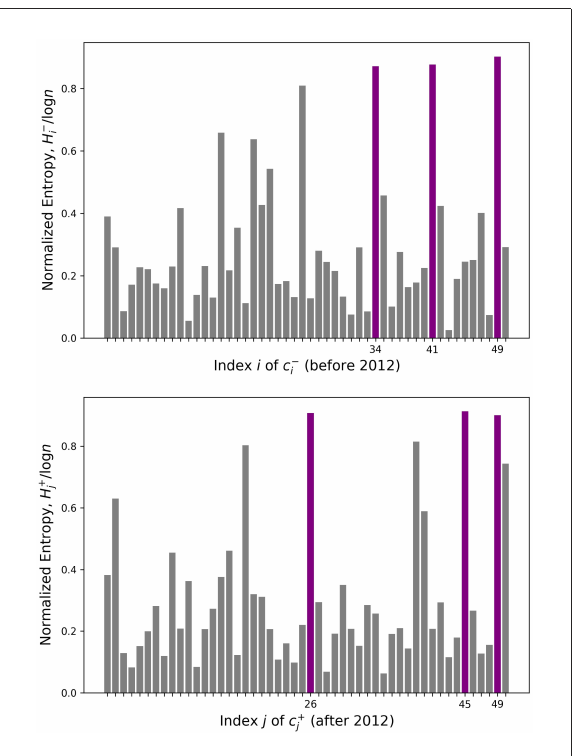
FIGURE2 Entropy for every before and after topic. Three highlighted topics have the highest entropy.